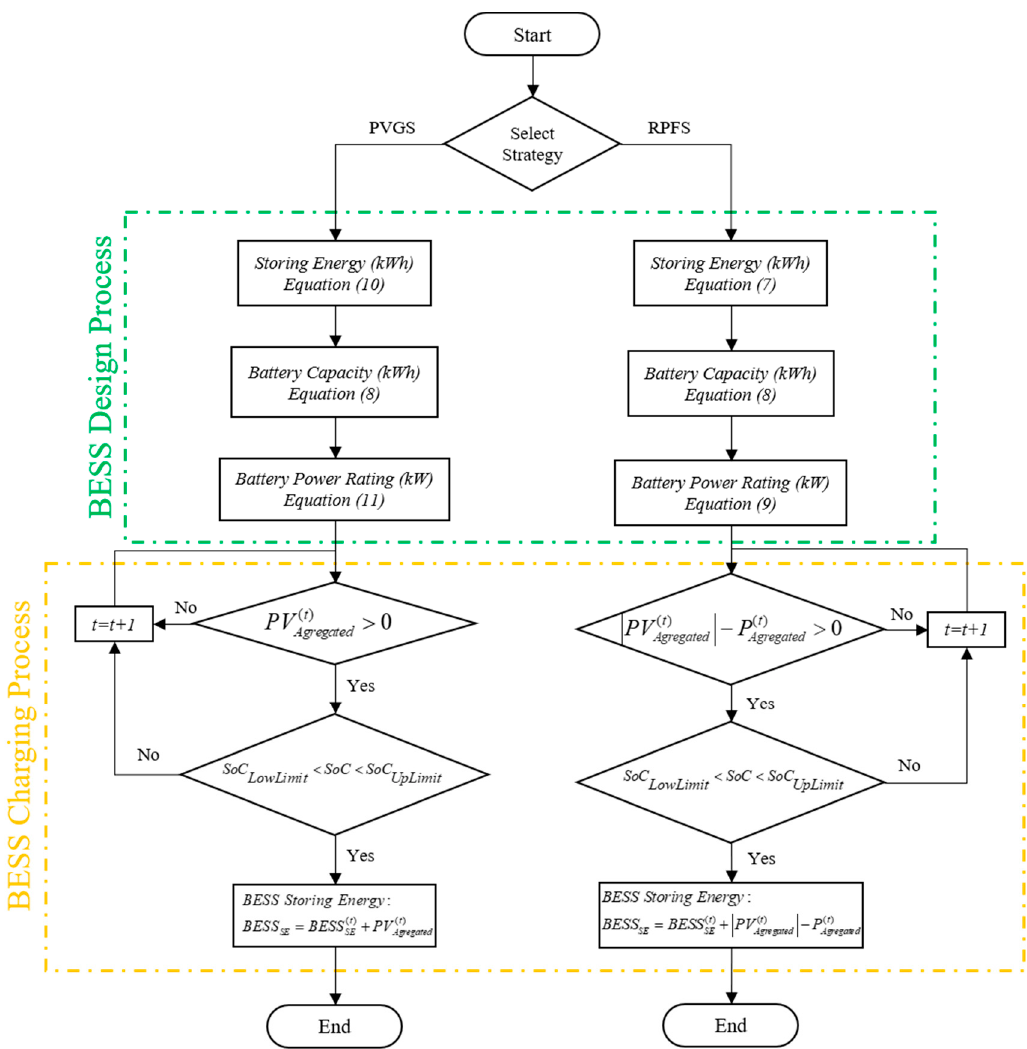
Figure 7. The BESS design and charging process for both reverse power flow strategy (RPFS) and PV generation strategy (PVGS) strategies.